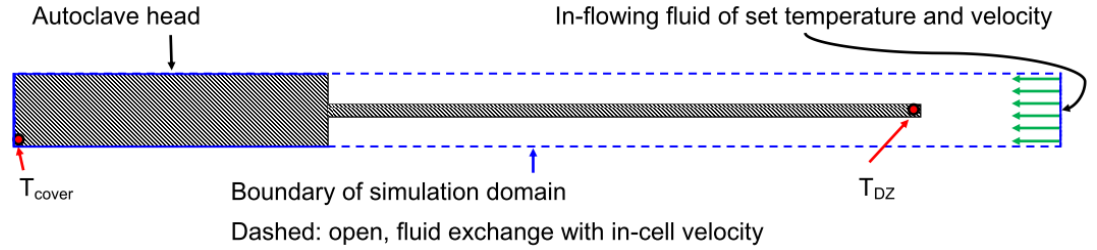
Figure 2. Simulation domain used to study the effects of heat capacity and heat conduction of internal thermocouples on the measurement results. The figure has been rotated by 90°, thus, the force of gravity acts from left to right in this figure. See also Figure 1b to relate the simulation domain to the entire experimental setup.